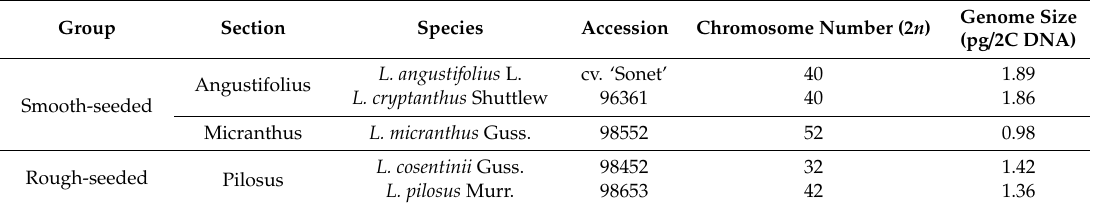
Table 1. General characteristics of the lupin species used in this study